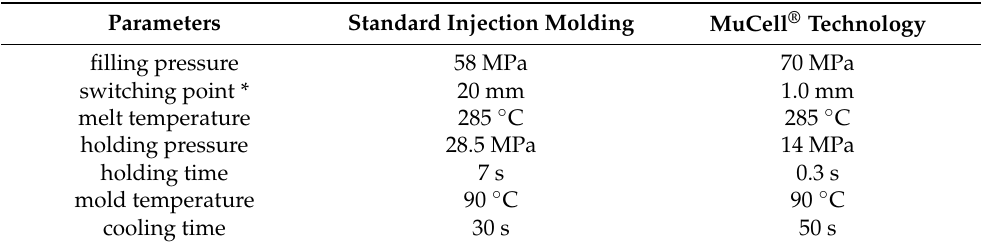
Table 1. Process parameters used during parts production in standard injection molding and MuCell ® technology.